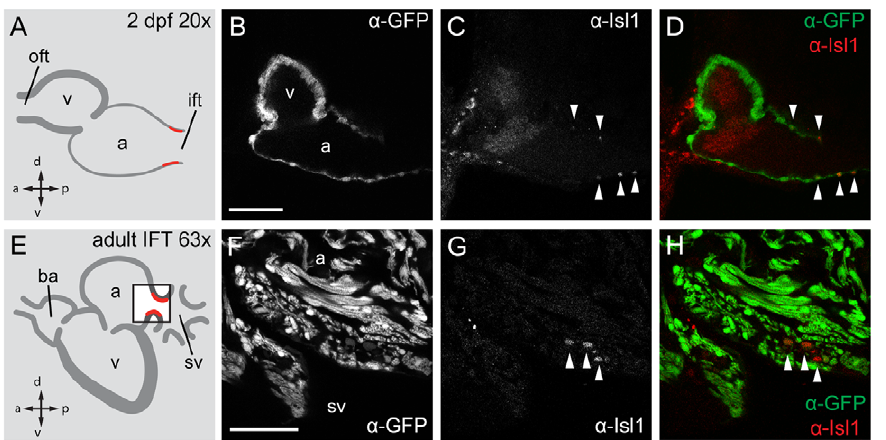
Figure 2. Isl1 expression in the embryonic and adult zebrafish heart. Single confocal scans of a fluorescent antibody labeling of Isl1 and eGFP in embryonic (2 dpf) ( A–D ) and adult ( E–H ) zebrafish expressing Tg(myl7:eGFP) in all cardiomyocytes. GFP + cardiomyocytes are displayed in grey (B, F) and in green in (D, H). Isl1 is shown in grey (C, G) and in red (D, H). Arrowheads indicate Isl + /GFP + cells. Illustrations of a lateral view of a 2 dpf (A) and adult (E) zebrafish heart indicate the location of Isl1 + cells (red). The box in panel E represents the area shown in (F–H). ( B–D ) Fluorescent immunolabeling of Isl1 and eGFP in a 2 dpf embryo (sagittal section 100 m m). At this time point Isl1 + /GFP + cells were only found in the IFT of the heart. ( F–H ) Fluorescent immunolabeling of Isl1 and eGFP in an adult zebrafish heart (sagittal section 100 m m). Isl1 + /GFP + cells are located at the junction of the sinus venosus and atrium in the inflow region of the heart (arrowheads). Isl1 + cells showed low expression of myl7 . v, ventricle; a, atrium; oft, outflow tract; ift, inflow tract; ba, bulbus arteriosus; sv, sinus venosus; a, anterior; p, posterior; d, dorsal; v, ventral. Scale bars